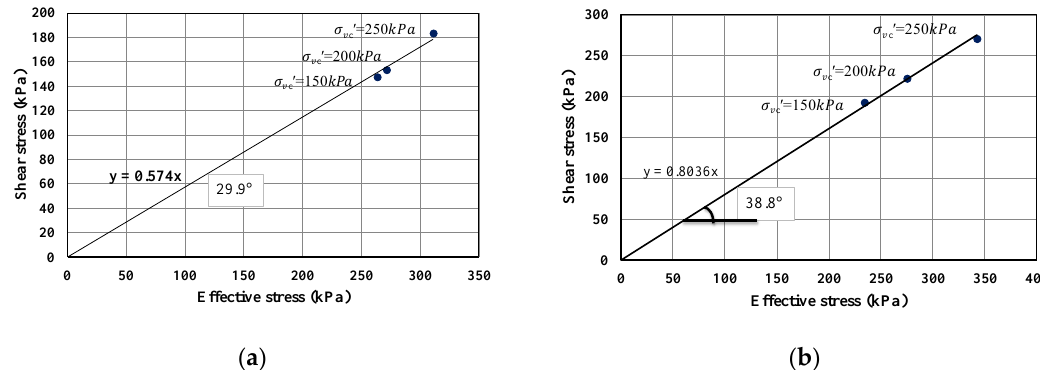
Figure 6. Effective internal friction angle (adapted from [21]): ( a ) Dr = 50%; ( b ) Dr = 85%.